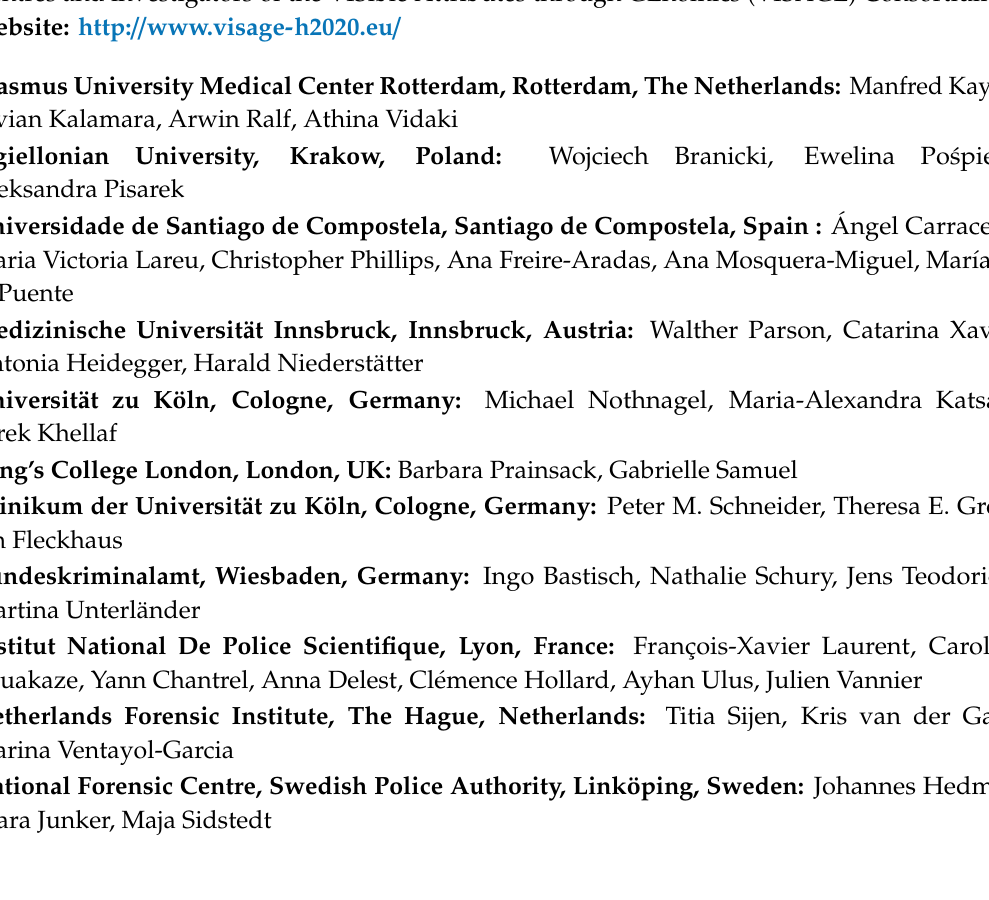
Figure S1: Distribution of the allele read frequency of heterozygote loci of every 2800 M Control DNA dilution. A continuous line marks the expected optimum (0.5) while the dotted lines indicate the lower and upper thresholds (0.4 and 0.6, respectively). (a) Allele read frequency of replicates with 1 ng DNA. (b) Allele read frequency of replicates with 0.25 ng DNA. (c) Allele read frequency of replicates with 0.125 ng DNA. (d) Allele read frequency of replicates with 0.05 ng DNA. (e) Allele read frequency of replicates with 0.01 ng DNA, Figure S2: Visualization of sequence alignment of the three replicates of 0.5 ng for rs1393350 with IGV from results obtained with the VISAGE BT A&A (PSeq) assay, Figure S3: Visualization of sequence alignment of sample NA18498 for rs2789823 with IGV from results obtained with the VISAGE BT A&A (PSeq)